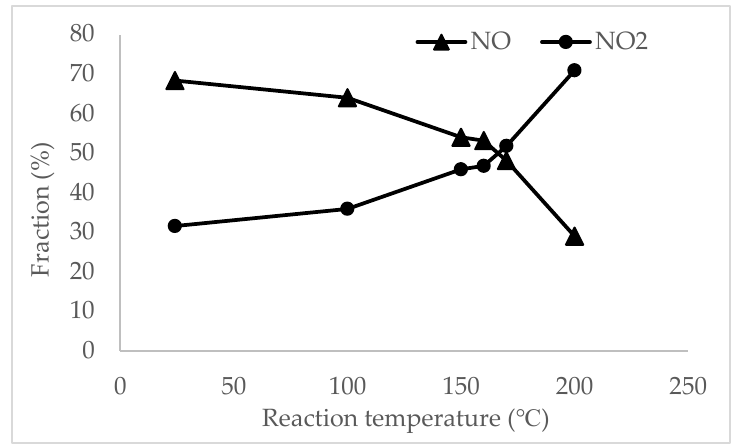
Figure 7. NO oxidation with respect to temperature of 9MnO